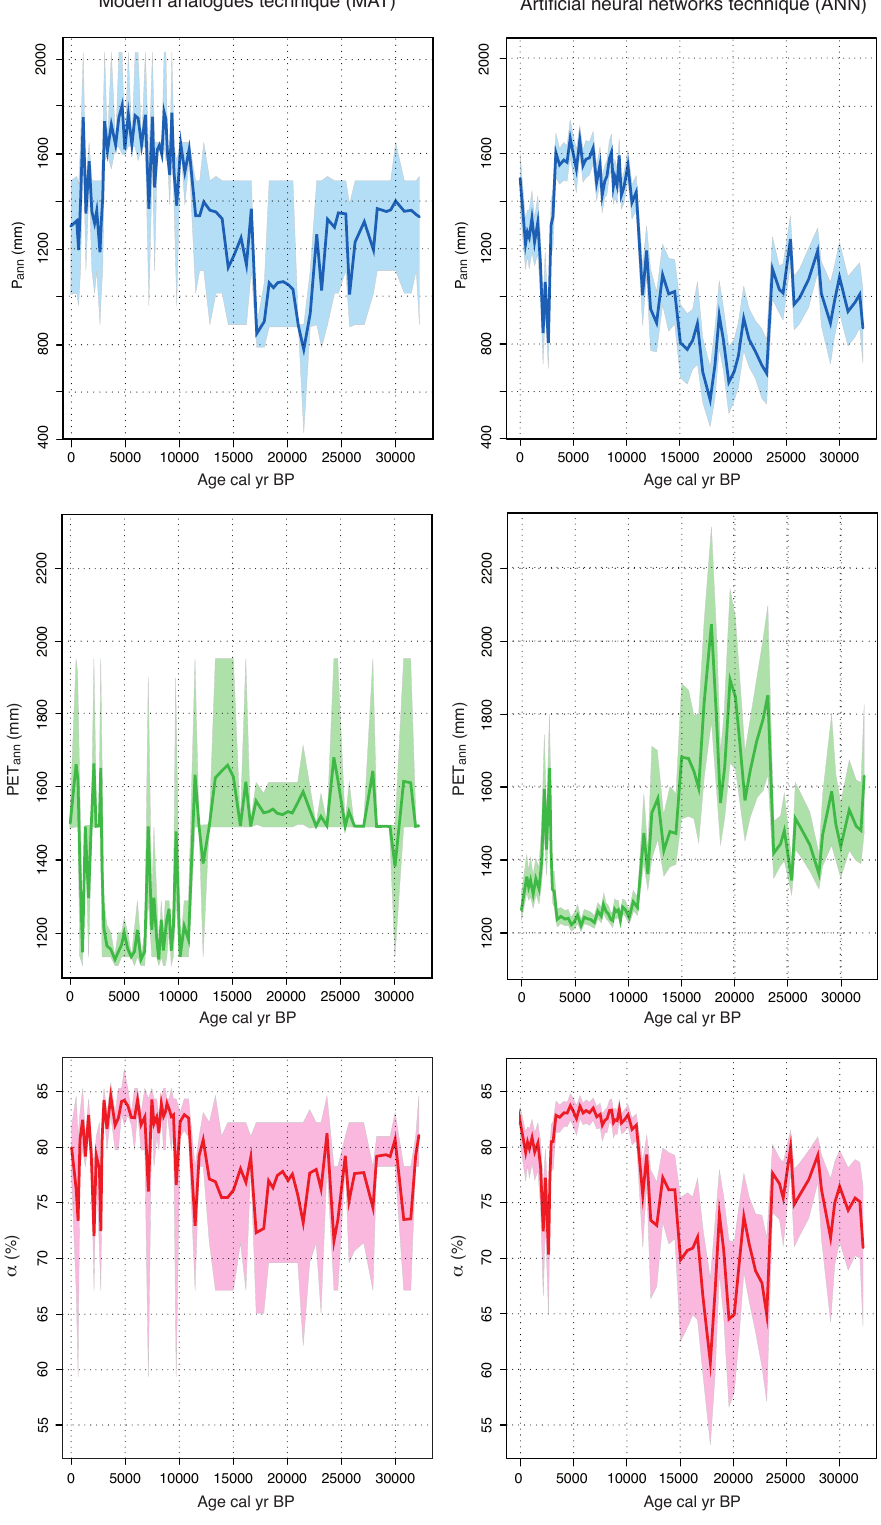
Fig. 6. Reconstructed climatic parameters ( P ann , PET ann and index α) along the Barombi Mbo pollen sequence.